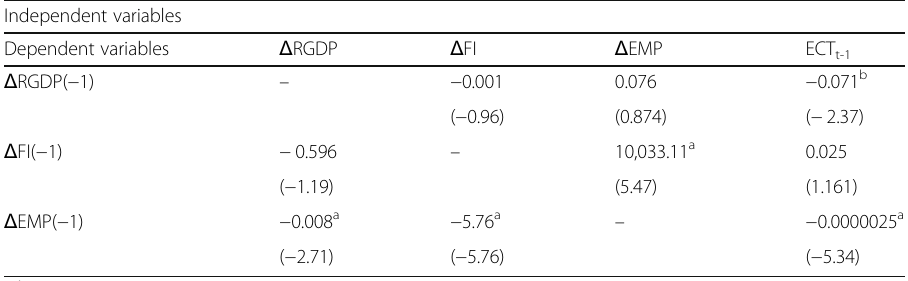
Table 6 Multivariate VECM Independent variables Dependent